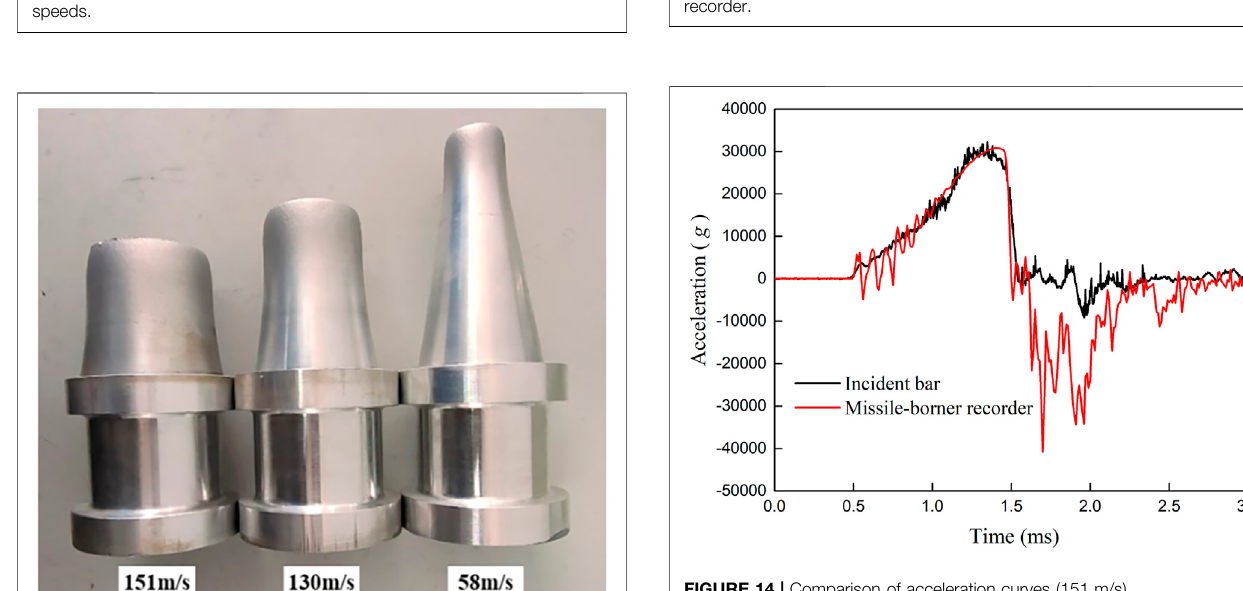
FIGURE 14 | Comparison of acceleration curves (151